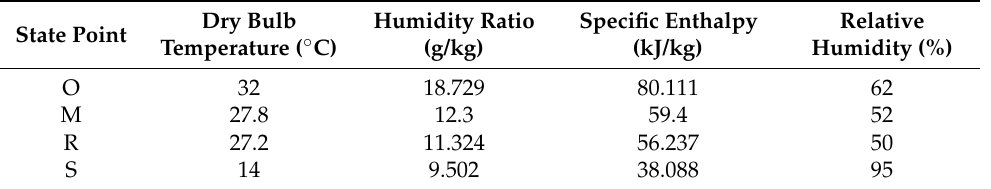
Figure 6. Psychrometric chart for air handling process. Table 5. Air state parameters of conventional all-air system.